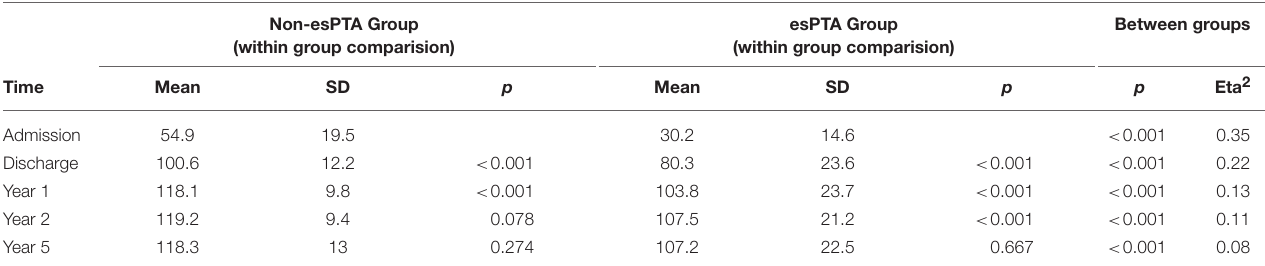
TABLE 2 | esPTA group and non-esPTA group’s FIM scores.